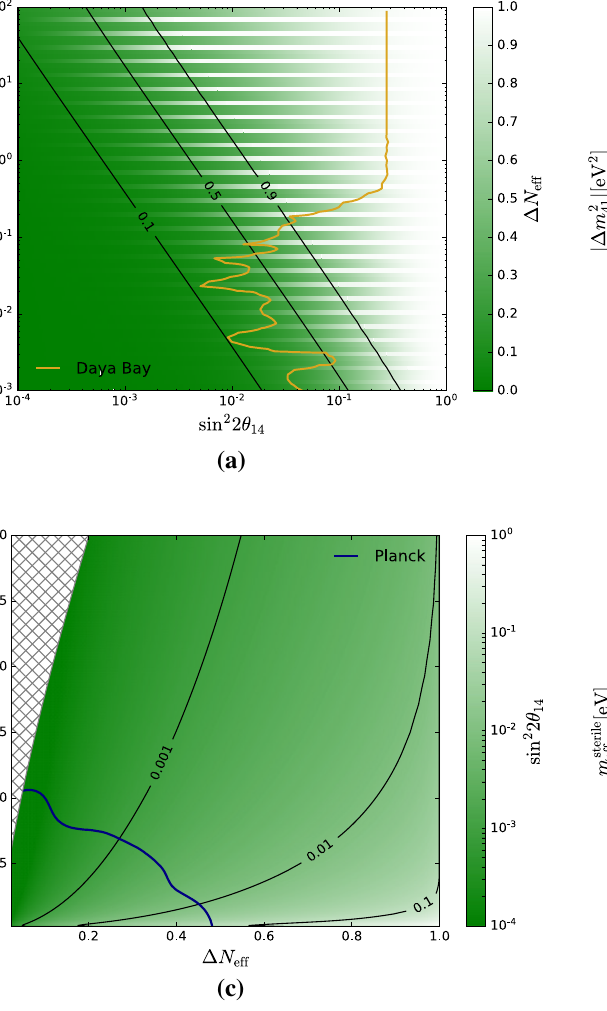
lation parameters of the 1 + 1 electron-neutrino disappearance model, and m sterile calculated, eff eff (cid:3) m 2 and sin 2 ( 2 θ 14 ) , in the cosmological space ( m sterile 41 region above the blue line is excluded by the Planck TT, TE, EE and low-multipole EE power spectra at the 95% Cl. A prior of m 4 < 10eV is applied, shown by the hatched region that has not been considered in our probability density